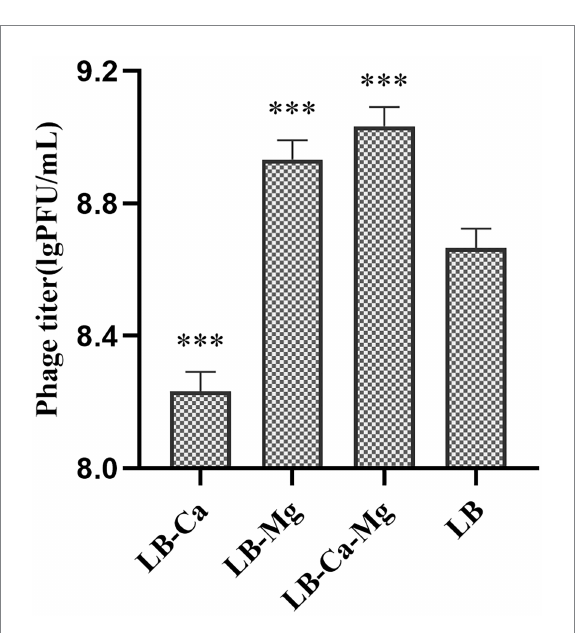
FIGURE 4 Effects of calcium and magnesium ions on the growth of PaVOA. *** p ≤ 0.001.